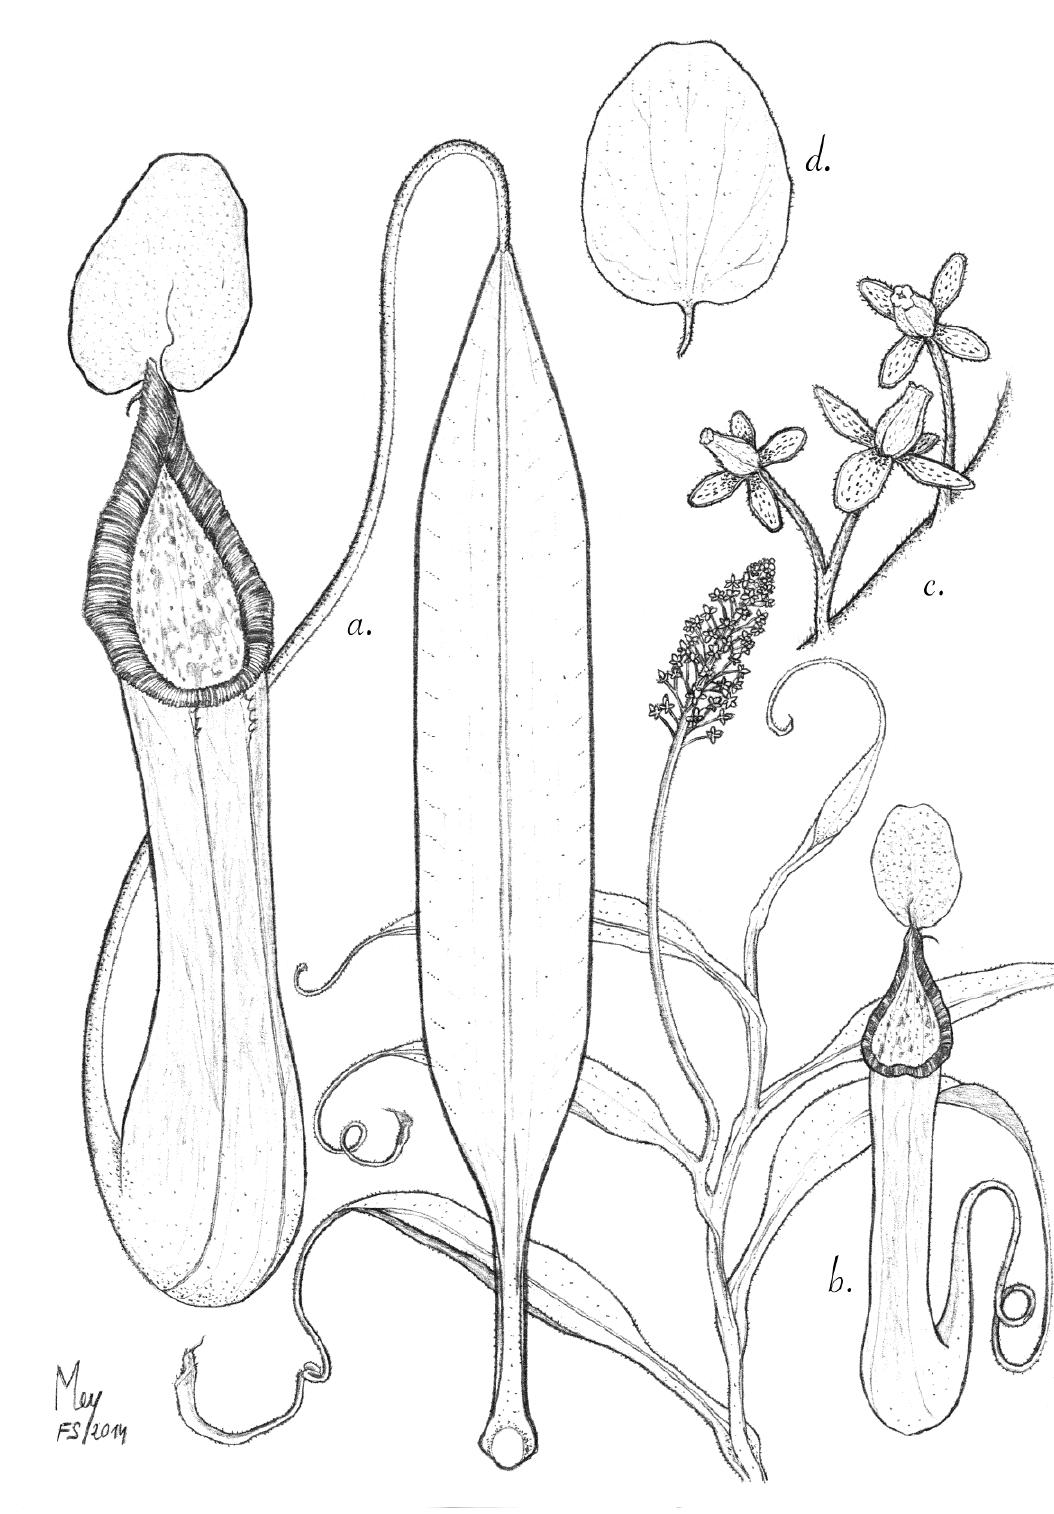
Figure 1. N. pantaronenesis . ( a ) Upper pitcher with leaf; ( b ) habit with female inflorescence and upper pitcher; ( c ) partial inflorescence with female flowers; ( d ) upper surface of lid and